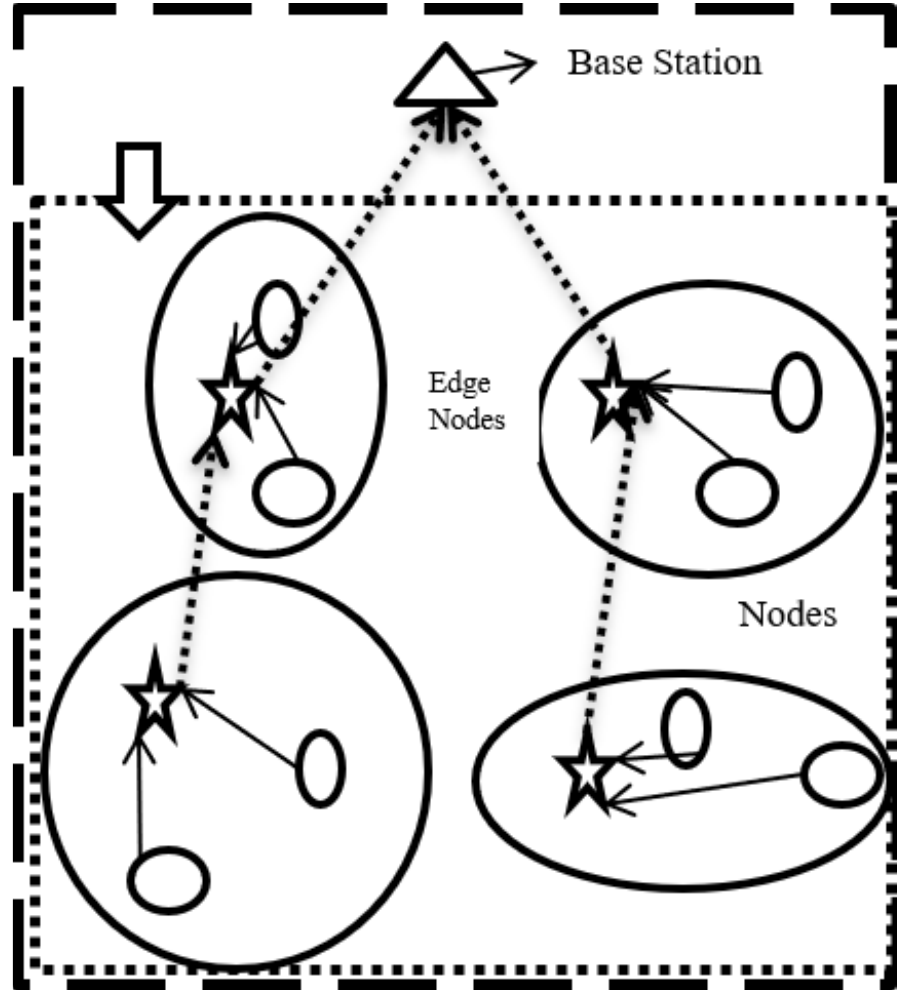
Figure 3. Network